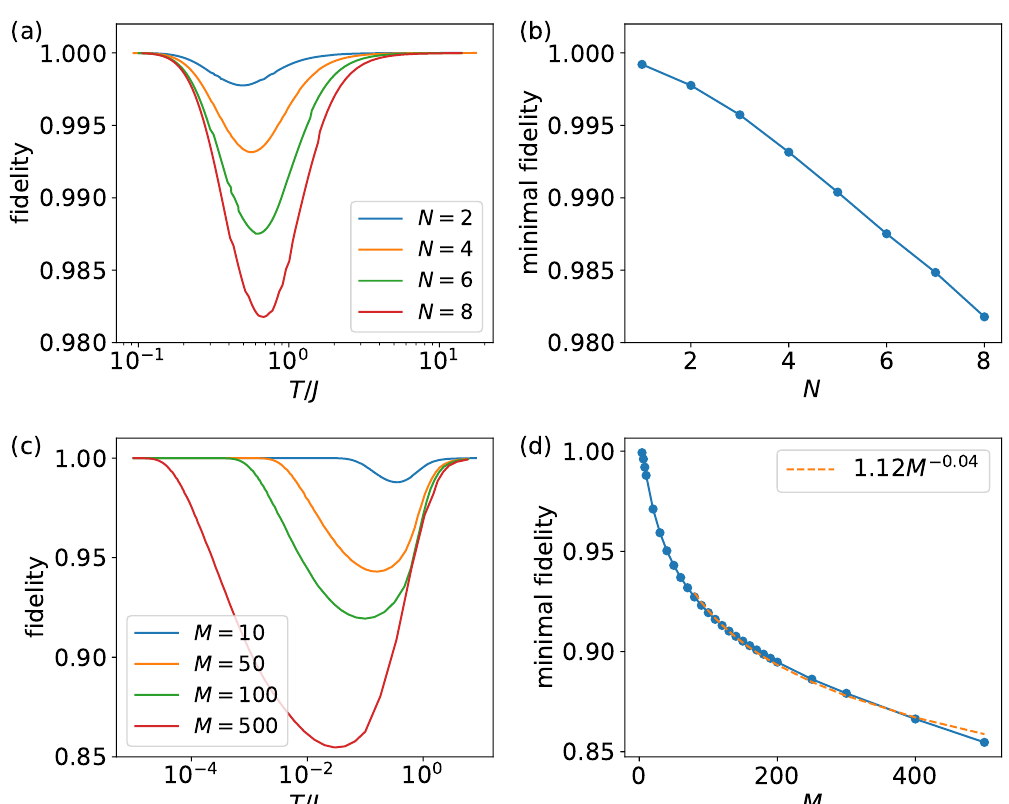
Figure 4: (a) The fidelity between the steady state and the corresponding thermal state as a function of T for various N . (b) The minimal fidelity vs N . (c) The fidelity between the steady state and the corresponding thermal state as a function of T for various M . (d) The minimal fidelity vs M . The parameters are M = 4 for (a) and (b), N = 1 for (c) and (d), U = 0, and γ = 0.001 J